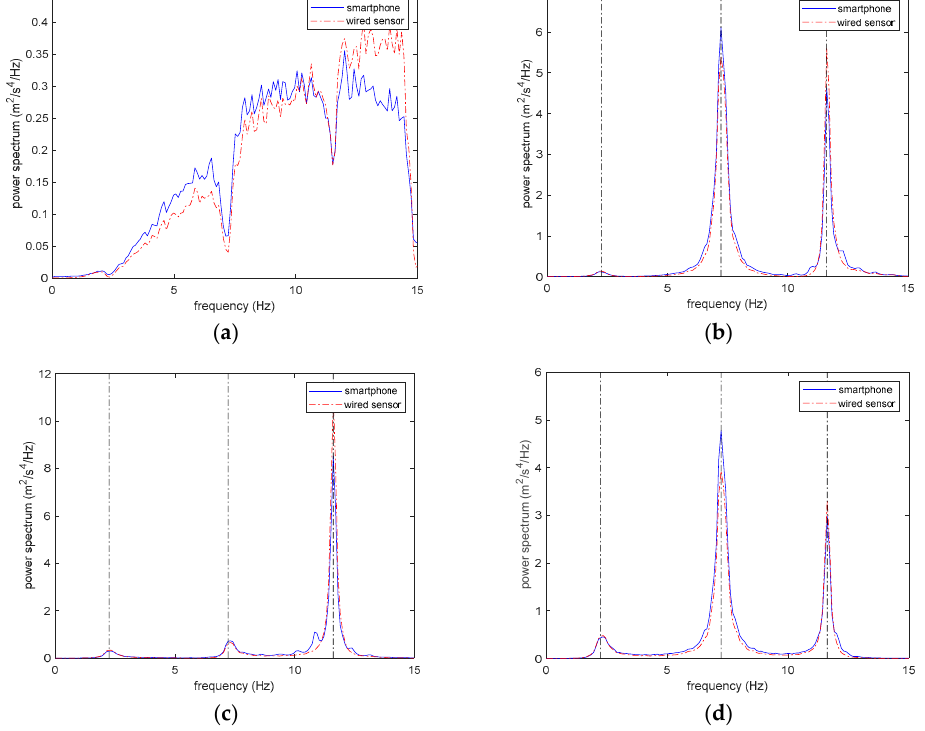
Figure 21. Comparison of power spectra of structural accelerations measured by smartphones and wired sensors: ( a ) base excitation; ( b ) 1st floor acceleration; ( c ) 2nd floor acceleration; ( d ) 3rd floor acceleration.